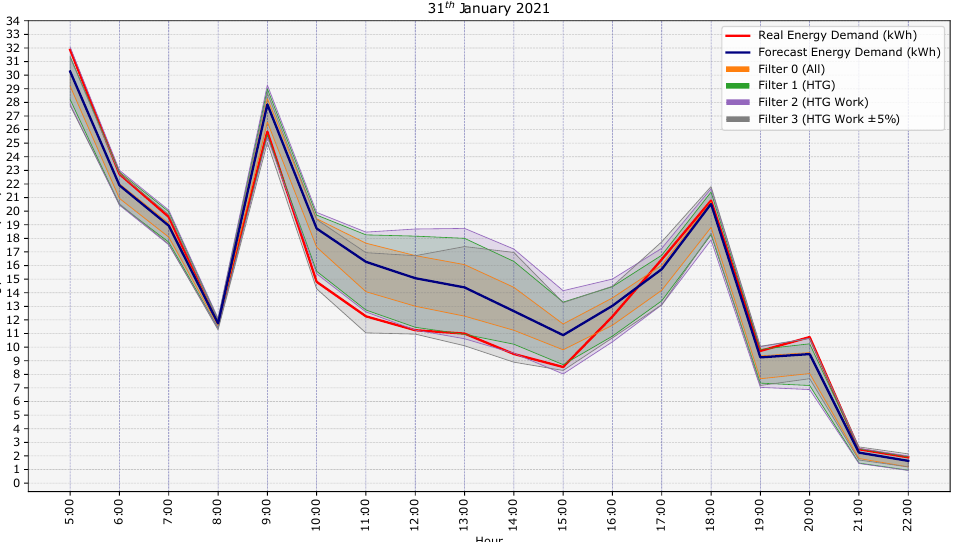
Figure 7. Graphical results of the PLF for the four filters for the last day of the test